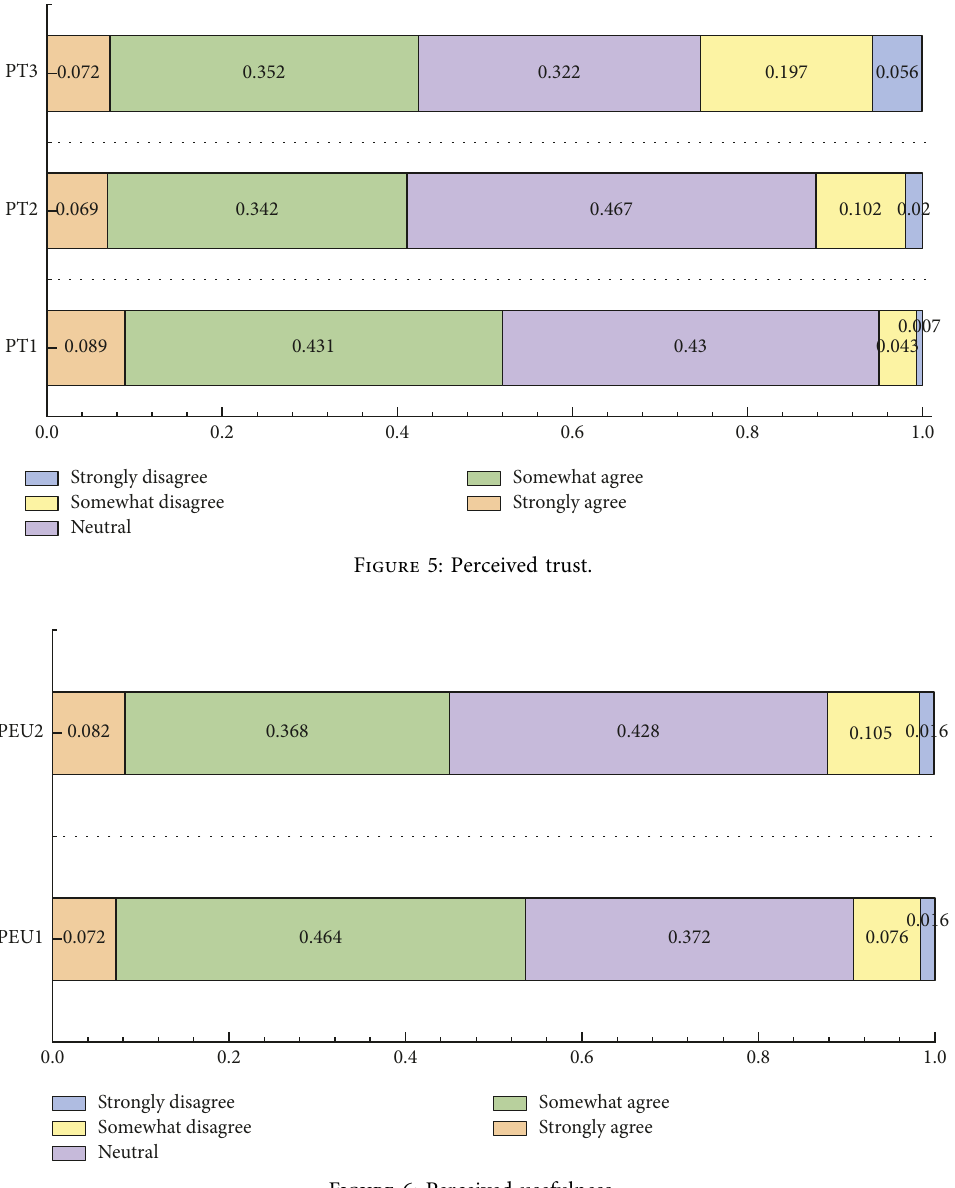
Figure 6: Perceived